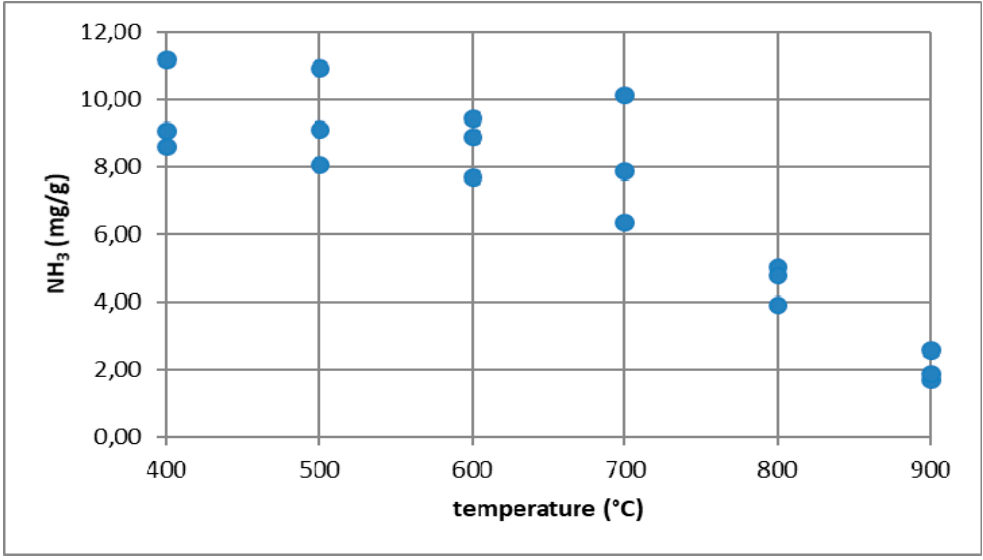
Figure 16. Ammonia emission from the combustion of rye straw. Atmosphere 2020 , 11 , x FOR PEER REVIEW